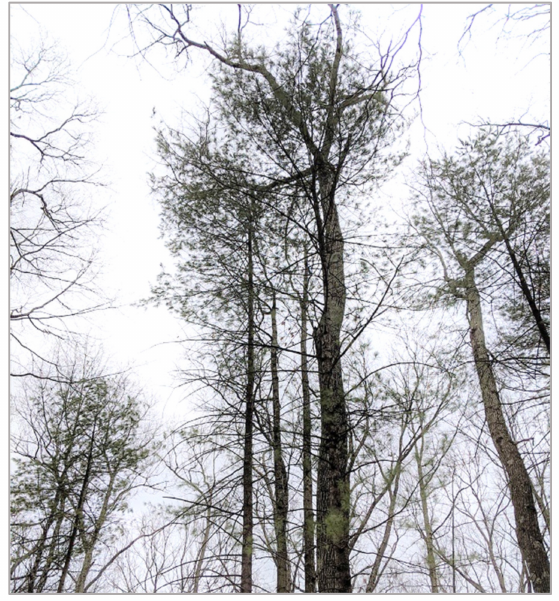
Figure 22. A 54 cm black oak not detected, potentially due to being surrounded by eastern white pines, which likely contributed to diffusion of the LiDAR pulses.